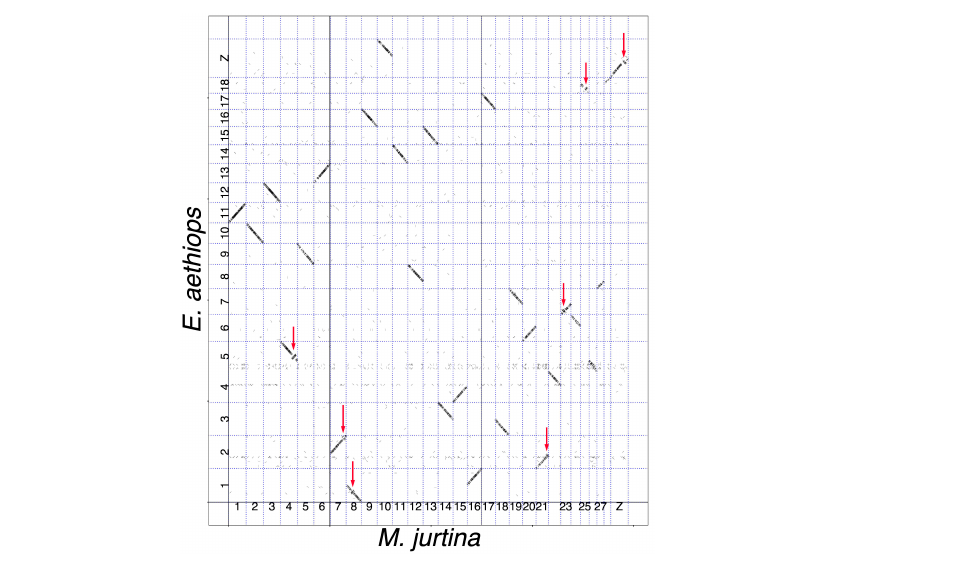
Figure 2. Genome of M. jurtina (horizontal axis) plotted against genome of E. aethiops (vertical axis). It can be seen that chromosome 1 jurtina corresponds to chromosome 11 aethiops , chromosome 2 jurtina corresponds to chromosome 10 aethiops , chromosome 3 jurtina corresponds to chromosome 12 aethiops , chromosome 4 jurtina corresponds to chromosome 5 aethiops , and so on, and chromosomes Z + 10 ligea correspond to chromosome neo-Z aethiops . Each short stroke represents a single syntenic block (a sup- ported alignment), positioned according to its position in the genomes of the compared species. All compared chromosomes are syntenic. Seven pairs of chromosomes show the presence of inversions (shown by red arrows).